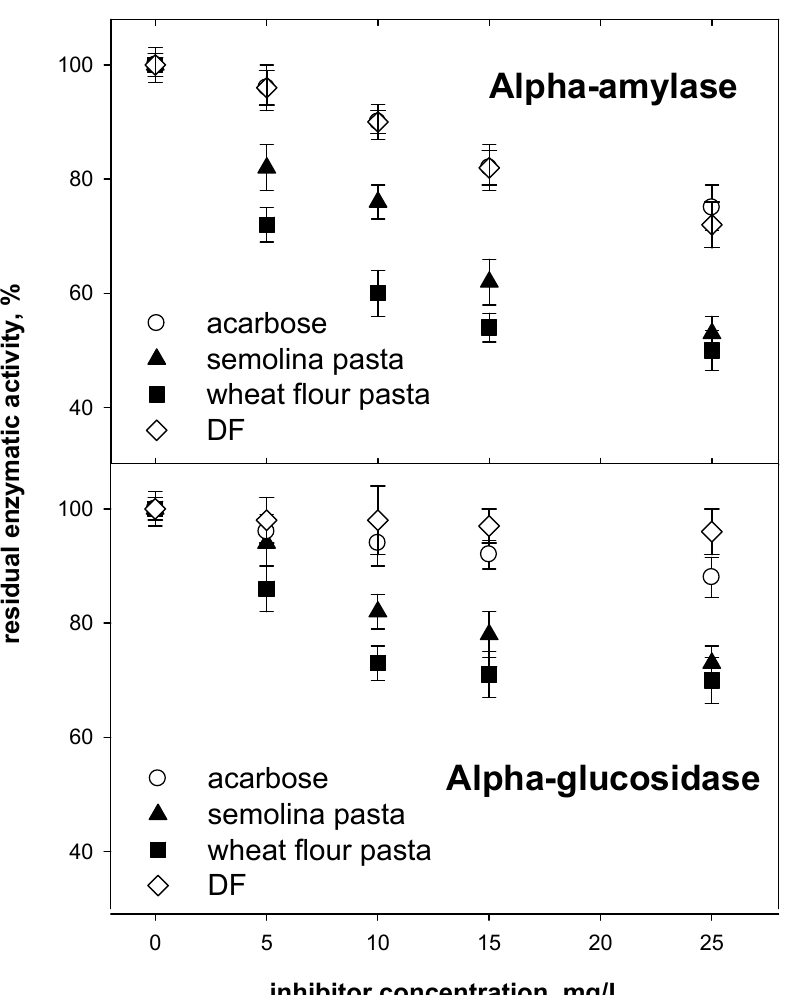
Figure 1. Inhibition of pancreatic alpha-amylase (upper panel) and brush-border alpha-glucosidase (lower panel) by HCl-ethanol extracts from cooked pasta, the original debranning fraction (DF), and by the reference drug, acarbose. Concentration of bioactives in extracts from either type of cooked pasta and from the debranning fraction (DF) is given as cyanidin equivalents. Results are reported as averages ± SD ( n = 3).